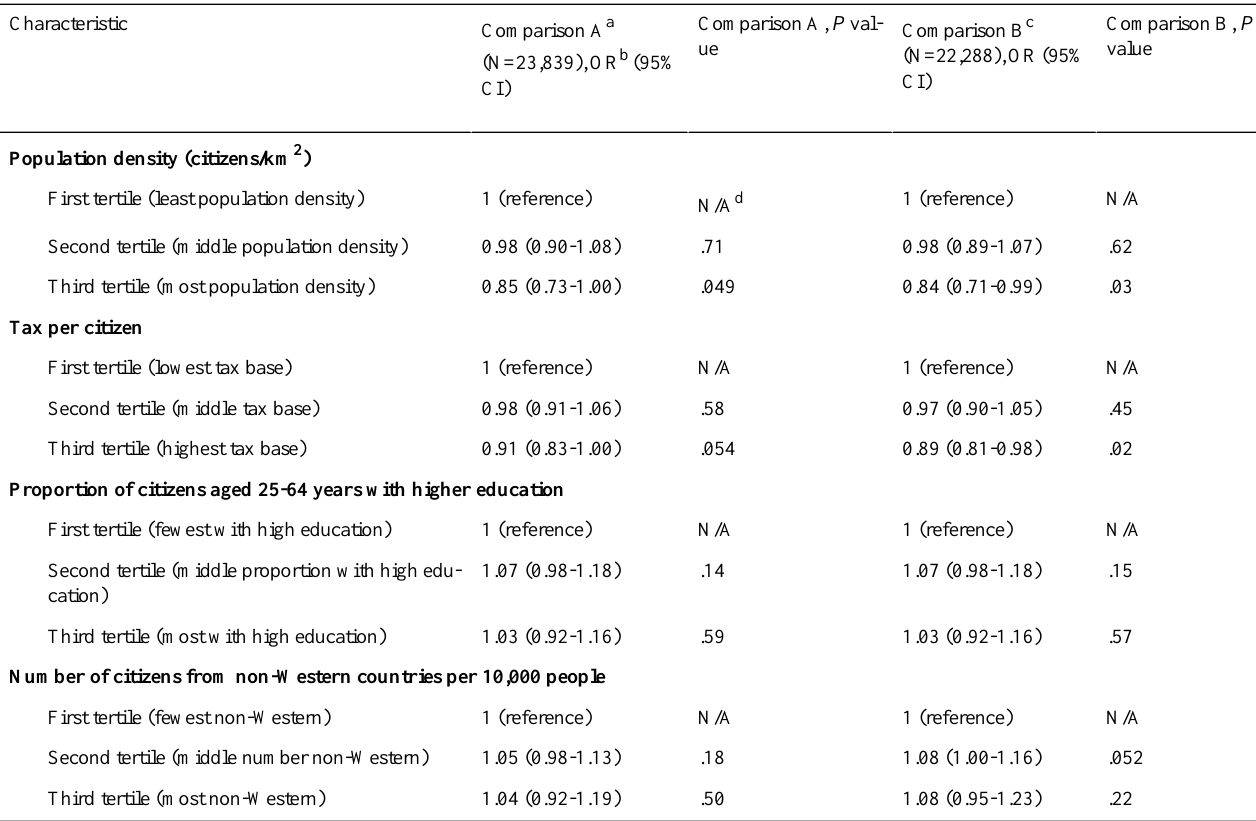
Table 7. Comparison of municipality-level characteristics adjusted for population density, tax per citizen, proportion with higher education, and number of citizens from non-Western